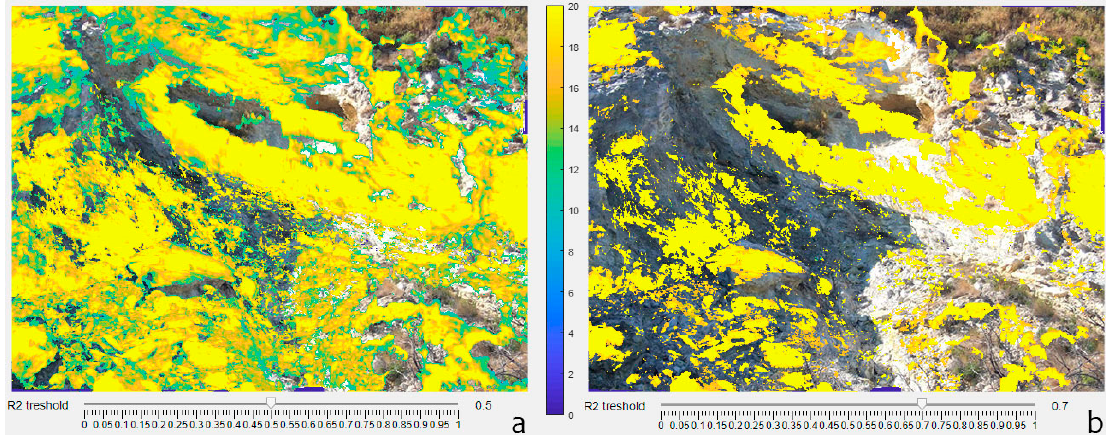
Figure 12. Yearly rate of temperature change maps of PS1 in the period 2016.03.10 – 2016.07.10. Map ( a ) has R 2 threshold value = 0.5. Map ( b ) has and R 2 threshold value = 0.7.